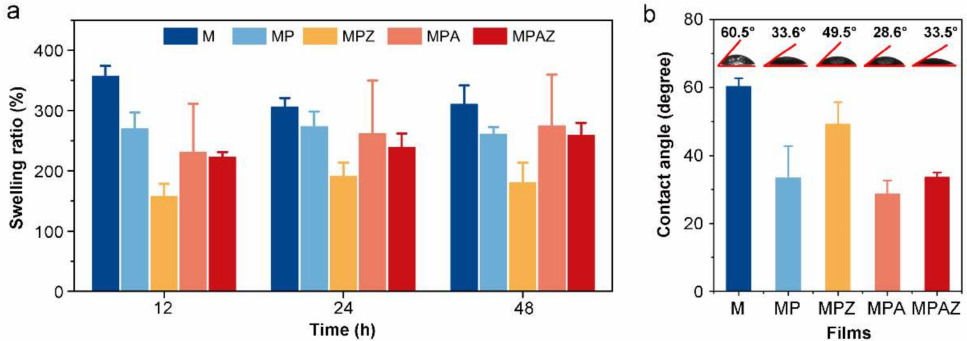
Figure 4. Swelling ratio and water contact angle of different films. a, Swelling ratio of the films; b, Water contact angle of the films.